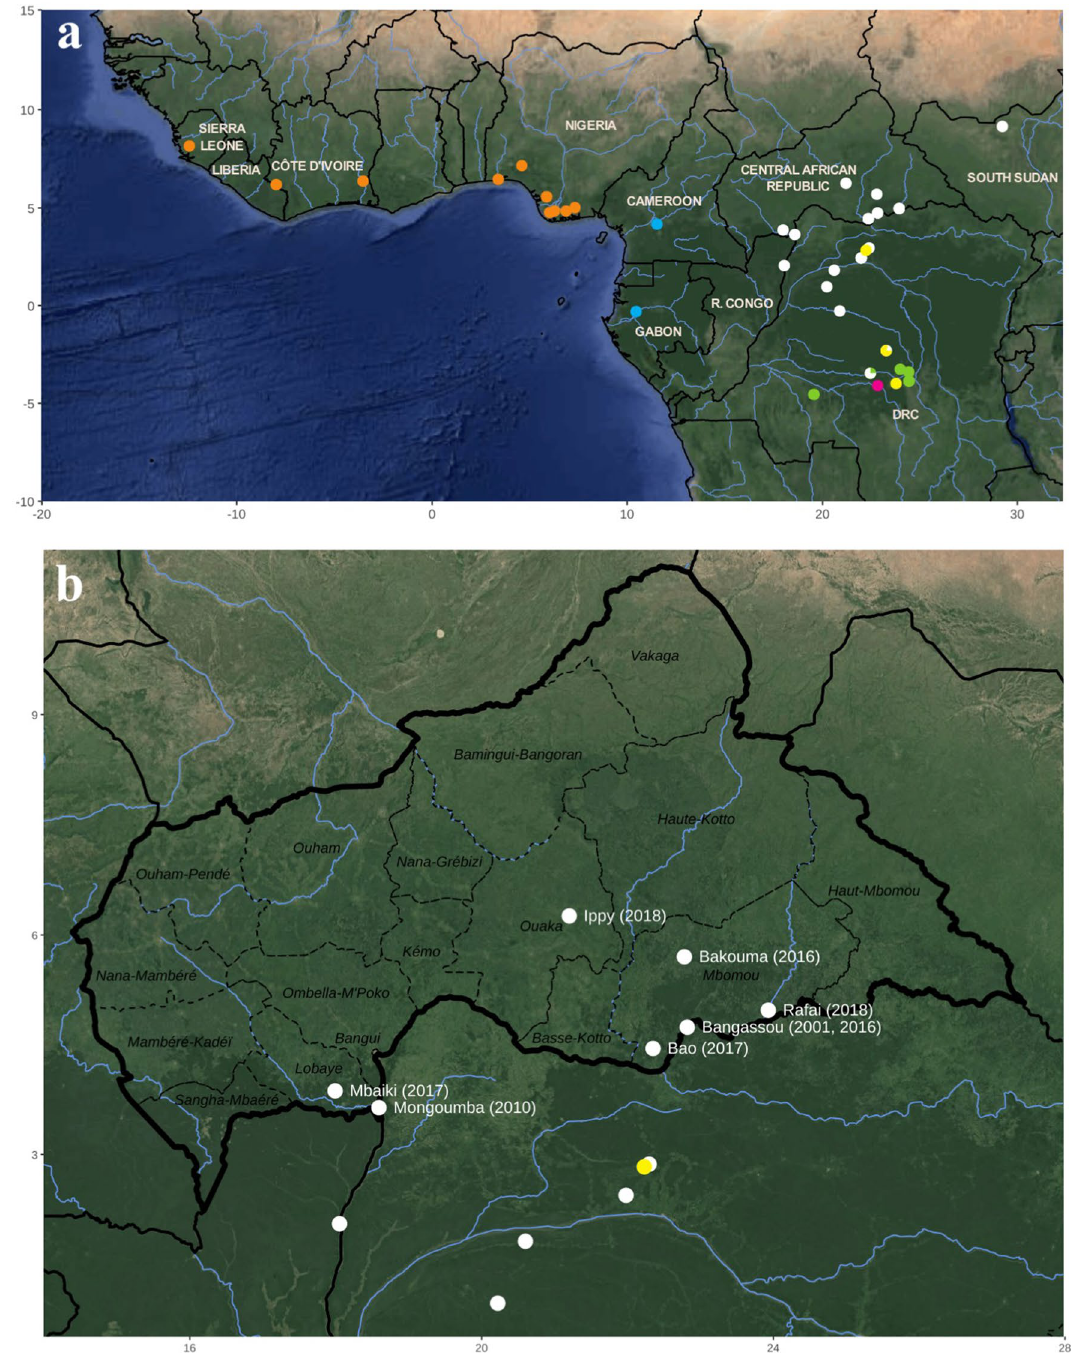
Figure 1. Geographic origin of the 56 monkeypox virus (MPXV) isolates analysed in this study ( a ). The 10 MPXV isolates collected in the CAR and specially sequenced for this study are indicated in the map of ( b ). The localities of reporting and years of these MPXV cases are indicated in white. As detailed in Fig. 2, the MPXV isolates belong to the West African clade (orange) or to the Central African groups I (blue), II (white), III (yellow), IV (green) and V (pink). The map was created with ggmap v3.0.0 under R 4.0.456. Maps Data: Google, 2021